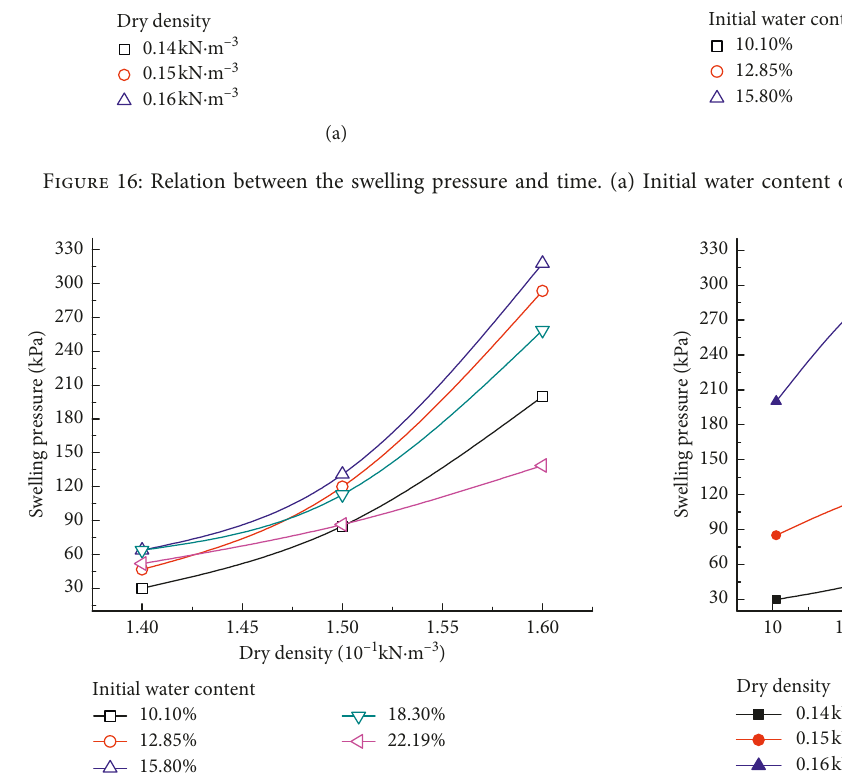
Figure 18: Relationship between expansive stress and moisture content for diverse dry